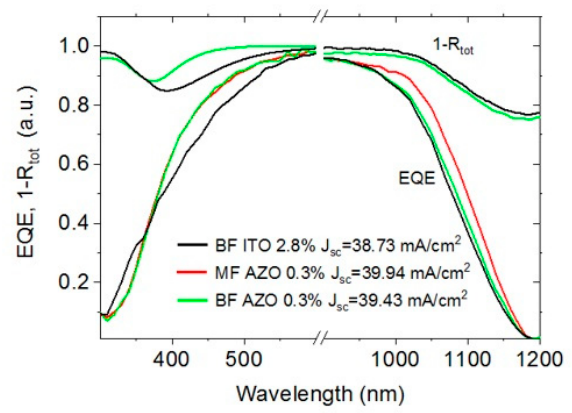
Figure 6. External quantum efficiency (EQE) and 1-R tot vs. wavelength of the solar cells with the highest power conversion efficiency of three groups. Monofacial and bifacial ZnO:Al solar cells (red and green lines, respectively) compared to a bifacial ITO reference solar cell (black line). For the 1-R tot spectra, only one of the ZnO:Al curves is shown since there is no difference between the monofacial and the bifacial cell on the UV-VIS reflection measurement of the front side.